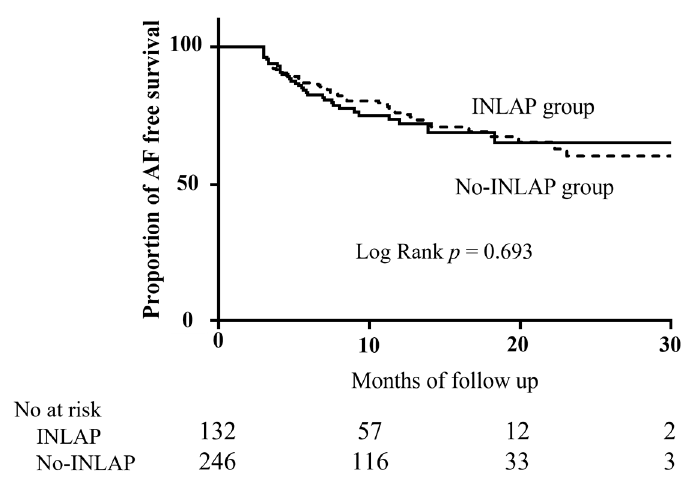
Figure 4. Kaplan–Meier curve of freedom from AF recurrence. Abbreviations: AF, atrial fibrillation; INLAP, inspiration-induced negative left atrial pressure.